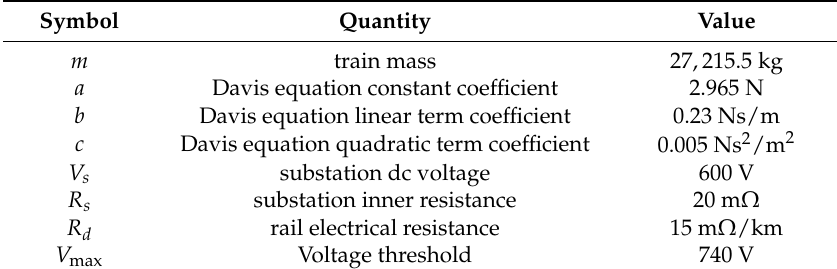
Table 1. Parameters of the Trains and the Electric Railway